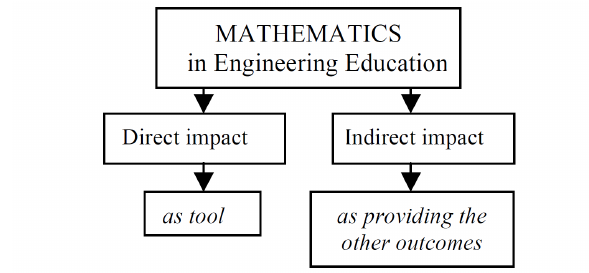
Figure 9. Mathematics impact in Engineering Education